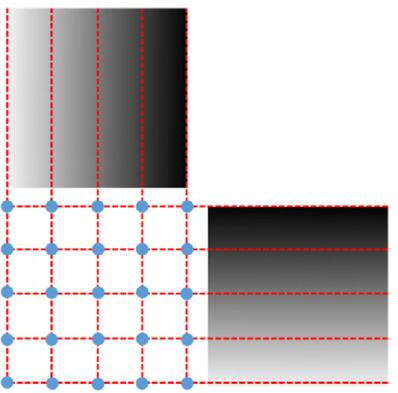
Figure 3. A schematic diagram of a standard pixel array structure. The standard pixel array is composed of x rows and y columns (the values of x and y are twice as the number of camera sensor pixels due to interpolation); the isophase lines obtained from the horizontal phase diagram, the phase values are, respectively, a , b ; the isophase lines obtained from the vertical phase diagram, the phase values are m and n , respectively. For each standard pixel, it contains two phase encoding values, a horizontal P ij ( h, v ) in the i -th row and j -th